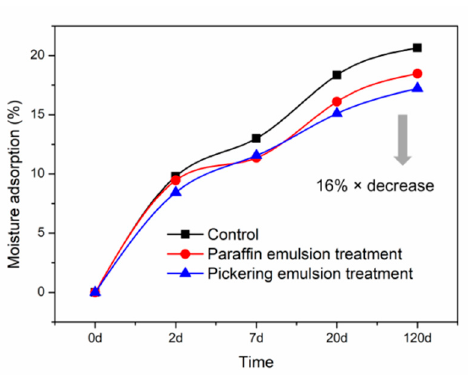
Figure 5. Moisture adsorption of untreated (control) and emulsion treated WFs.